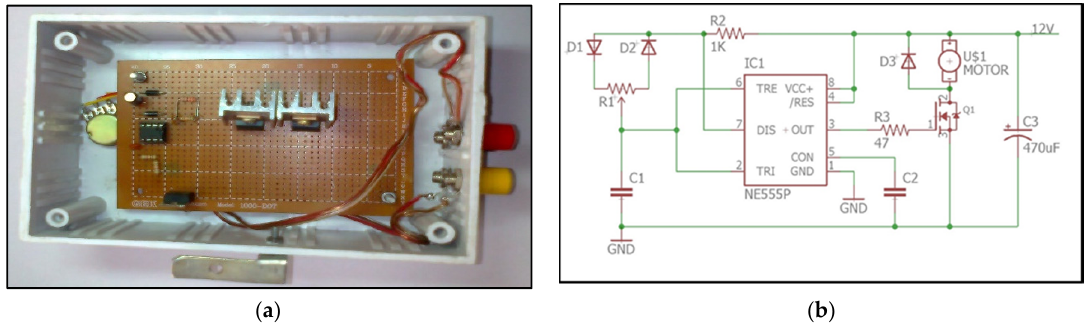
Figure 8. ( a ) Direct Current (DC) motor speed controller circuit and ( b ) its schematic diagram.